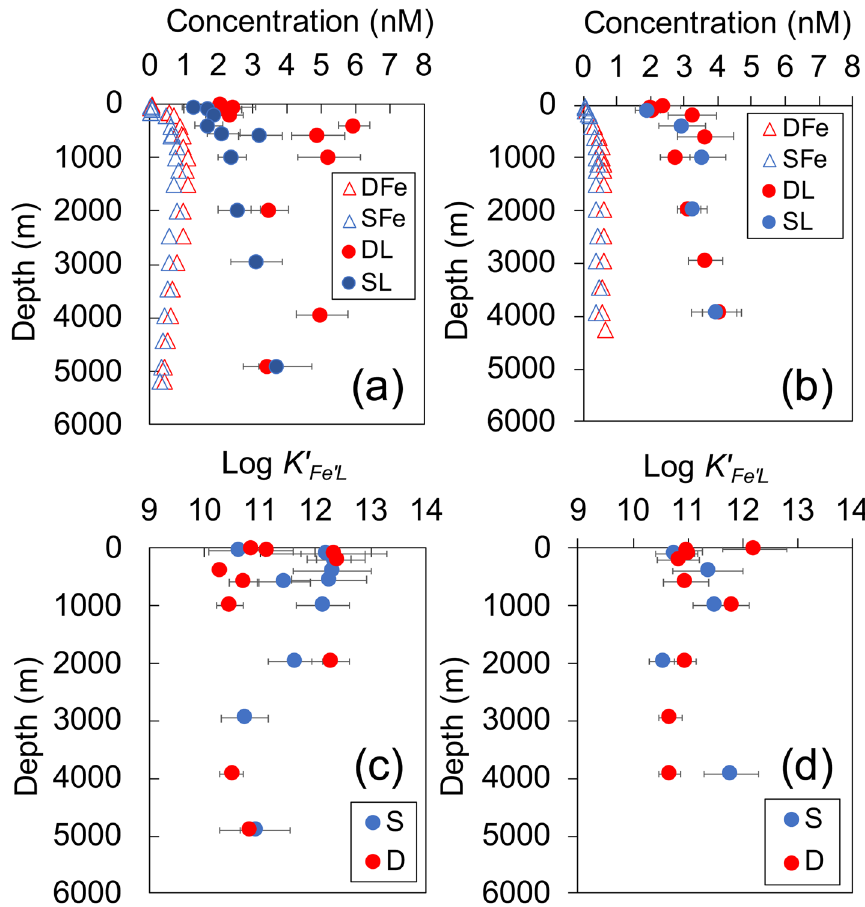
Figure 2. Vertical distributions of [D-Fe] (DFe, red open triangle), [S-Fe] (SFe, blue open triangle), [D-L] (DL, red closed circle) and [S-L] (SL, blue closed circle) at Stns. ( a ) CL2 and ( b ) CL16. Vertical distributions of the K ′ Fe ′ L (in log scale) of dissolved (D, red closed circle) and soluble (S, blue closed circle) fractions at Stns. ( c ) CL2 and ( d ) CL16. Error bars indicate analytical error from ProMCC